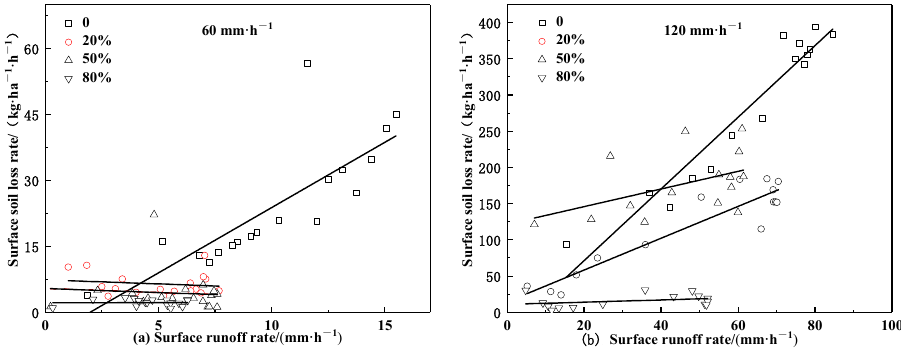
Figure 5. Relationship between surface runoff rate and surface soil loss rate in young lime soil citrus orchards at 60 mm/h ( a ) and 120 mm/h ( b ) rainfall intensities under different straw coverages. Under the conditions of heavy rain intensity (120 mm/h), the distribution of scatter points without straw coverage developed towards the upper-right corner, and when the rain intensity reached the stable state, the scatter point distribution was relatively concentrated. The slope of the scatter points’ fitting line without straw coverage at a heavy rain intensity was higher compared with a moderate rain intensity. The scatter distribution at 20% and 50% straw coverage tended towards the upper-right corner, and their surface runoff rate and surface soil loss rate were significantly lower than those without straw coverage. The scatter points at 80% straw coverage tended towards the right, the surface runoff rate and surface soil loss rate were both the smallest, and the surface soil loss rate did not increase with runoff intensity. The results show that straw